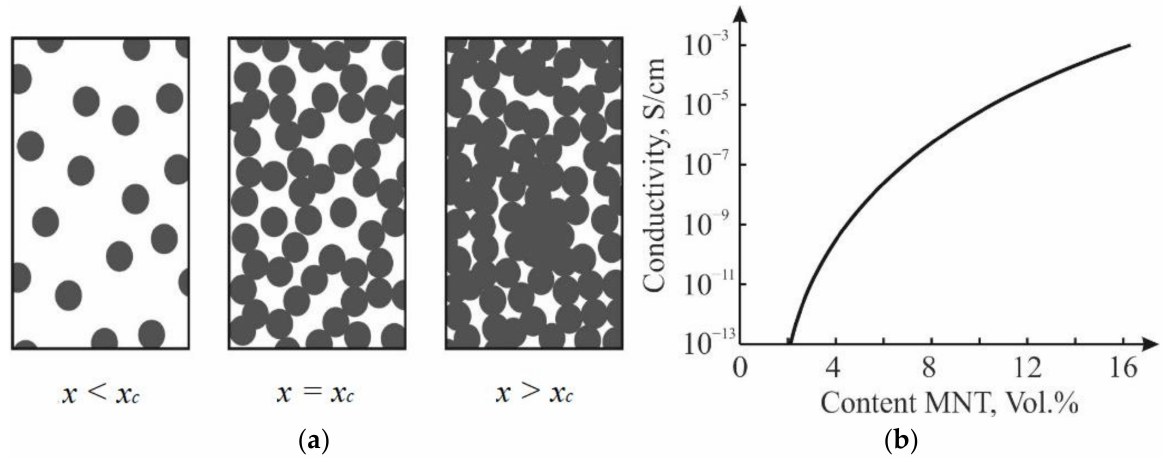
Figure 2. Percolation view in a conductor–polymer composite: ( a ) Appearance of the agglomeration of conducting particles at increasing concentrations; ( b ) conductivity in polymer polyamide with multiwalled nanotube (MNT) additives